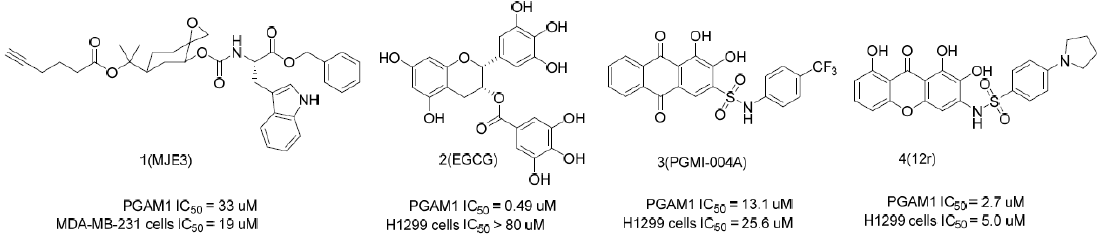
Figure 1. Reported phosphoglycerate mutase 1 （ PGAM1 ） inhibitors.